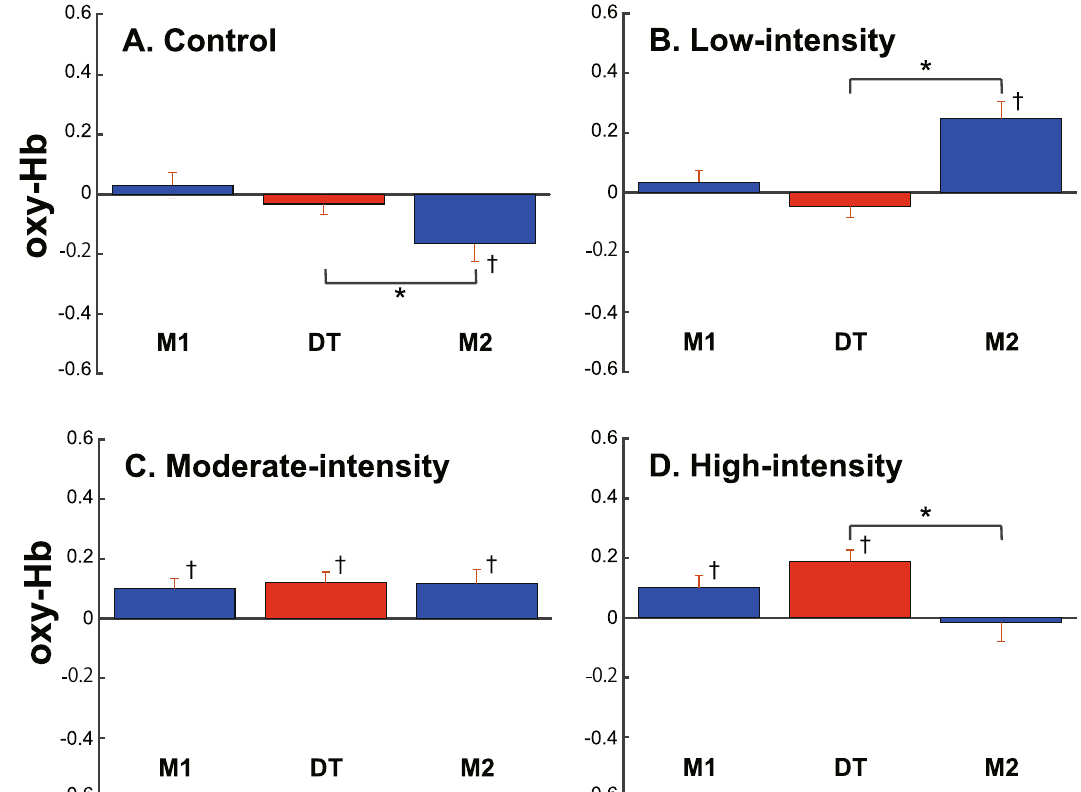
Figure 3. Normalized mean oxy-Hb concentration during the task for each exercise intensity. The oxy-Hb concentration was normalized by that in the resting period and averaged for each exercise intensity. Mean ± SEM. *A significant difference between the task conditions ( p < .05). † A significant difference from under the rest condition ( p <